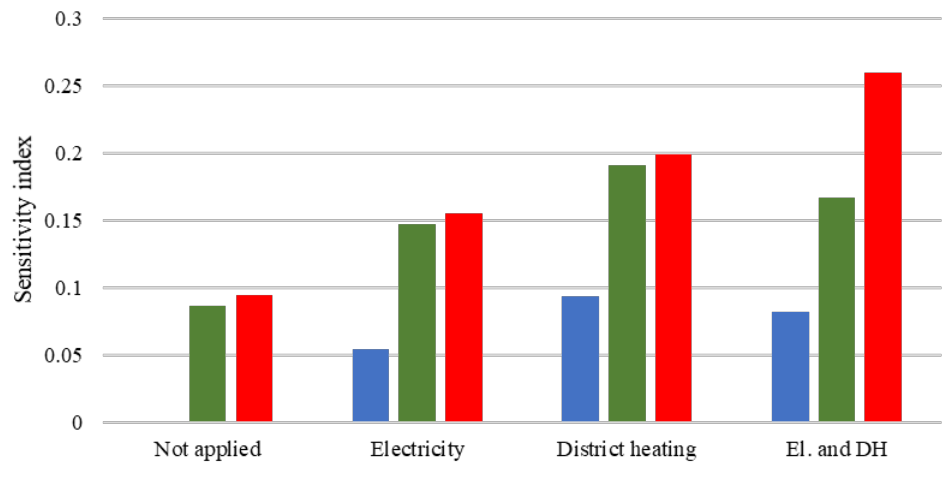
Figure 3. Sensitivity index for different discount rate (DR) types and price developments (PD) compared to the baseline (decreasing DR and no applied PD), considering 50-year calculation period.